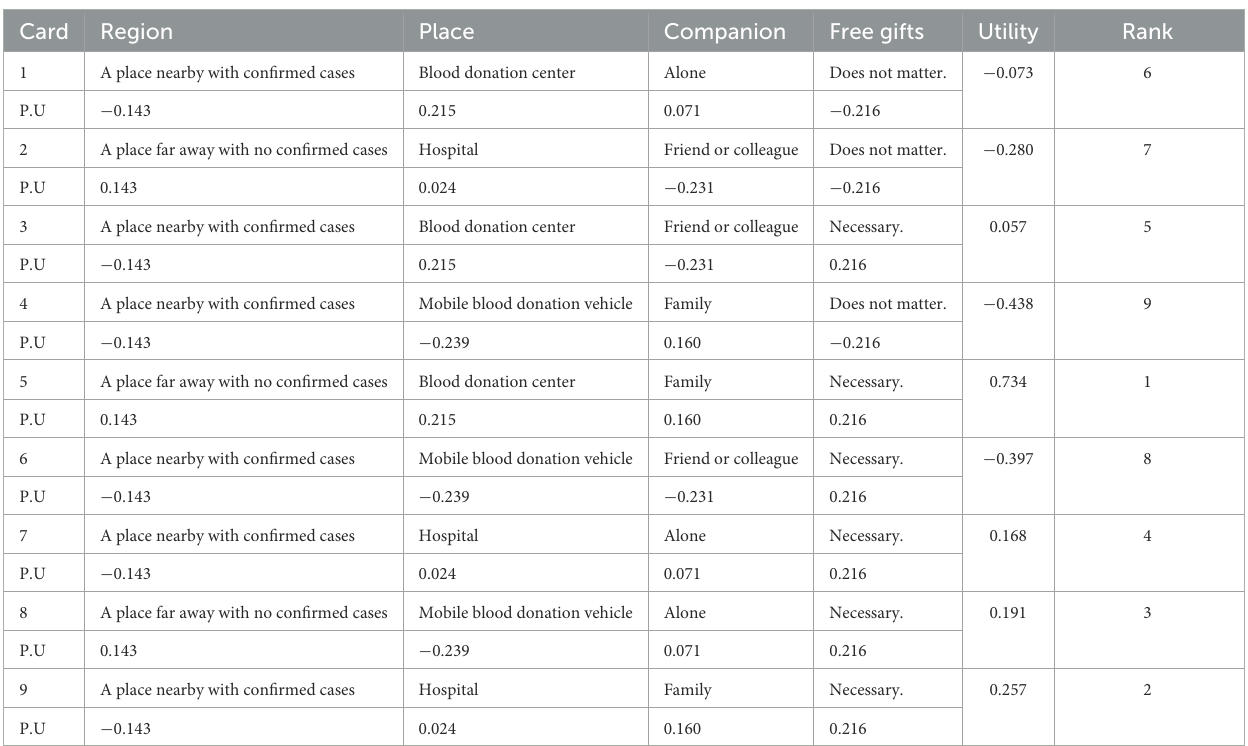
TABLE 7 Profile utility of the environment preferred by blood donors. Card